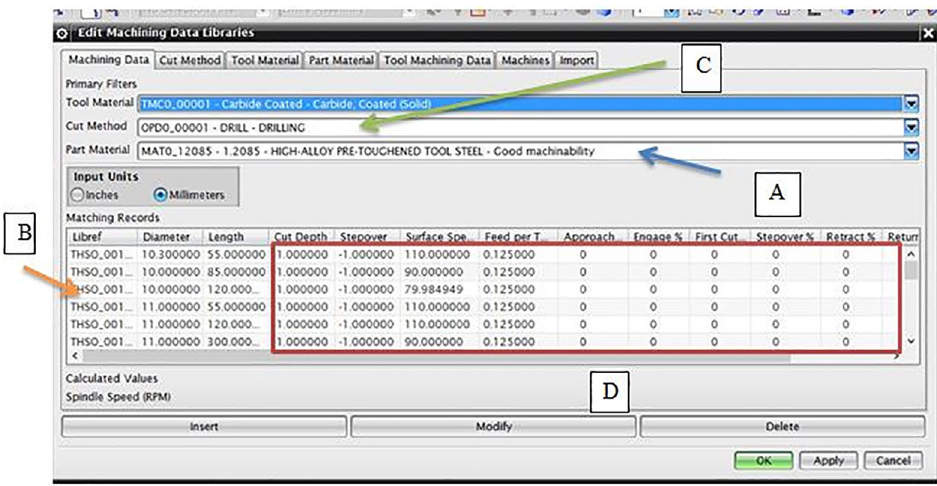
Fig. 8. Interconnection of databases. A – material, B – tools, C – operation type, D – feeds and speeds.